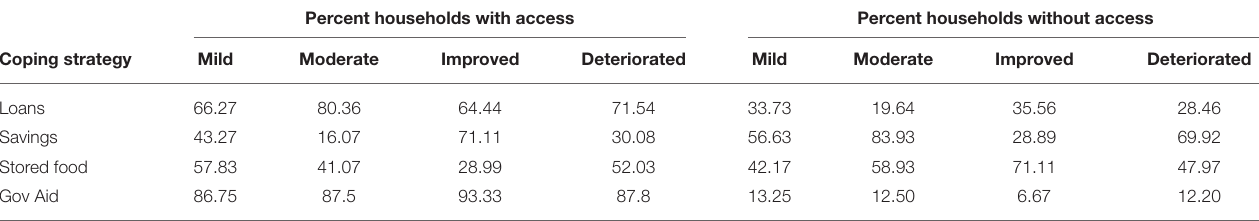
TABLE 5 | Household access to coping strategies based on FIES